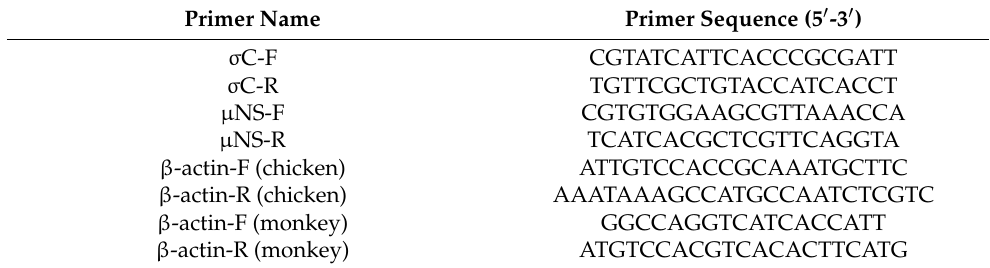
Table 1. The primer sequences for